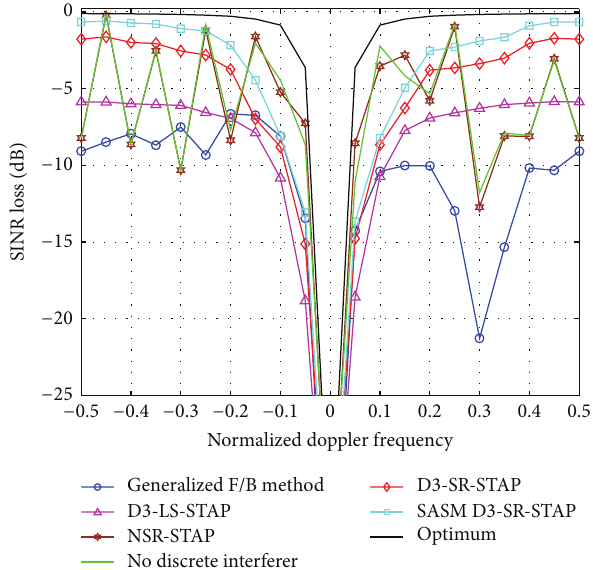
Figure 5: SINR loss against the target Doppler frequency in nonho- mogeneous